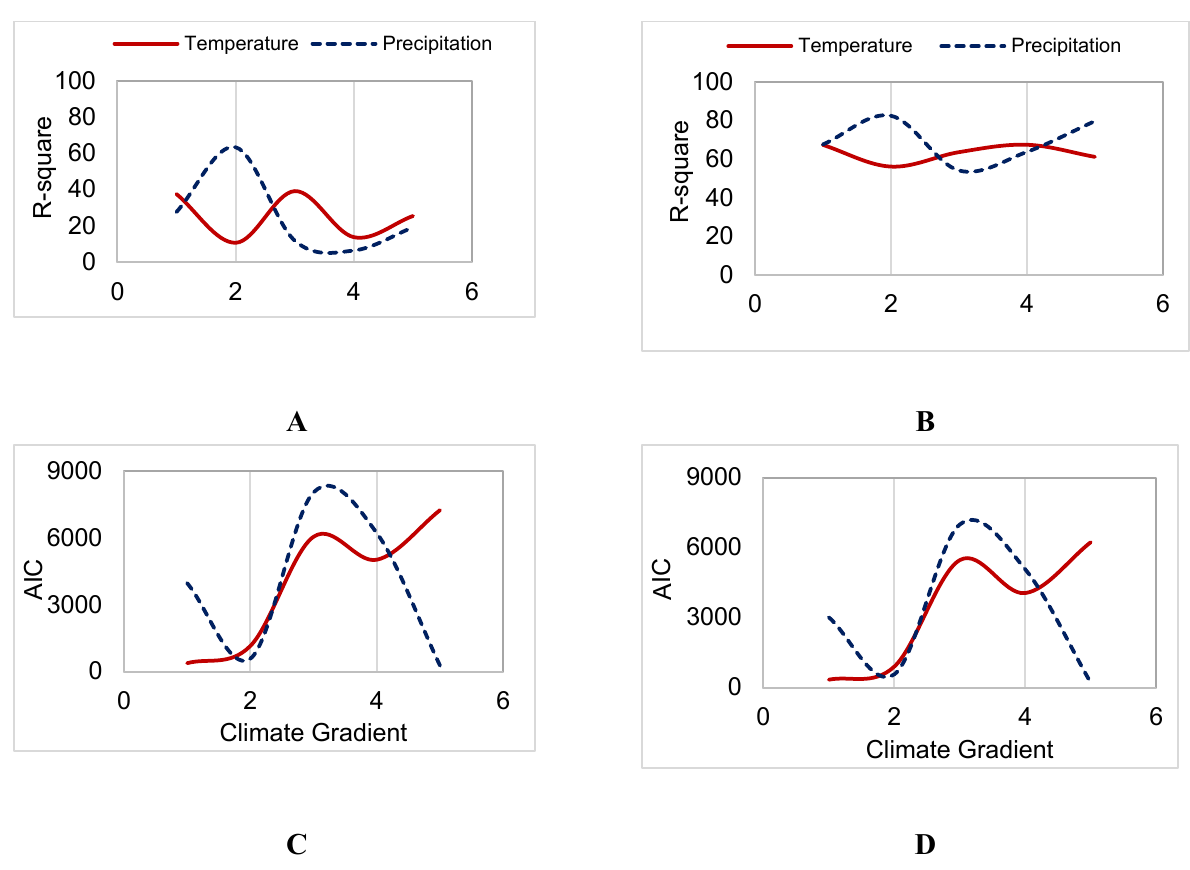
Figure 3. Changes in the strength of productivity response to aridity index ( A , C ) and stand dynamics (the combined effects of stand age, structure and composition) ( B , D ); measured with co-efficient of determination ( A , B ) and Akaike information criterion ( C , D ). The solid red line depicts the variability in the strength of the relationships along the temperature gradient, while the broken dark blue line reveals changes in the strength of the relationship along the precipitation